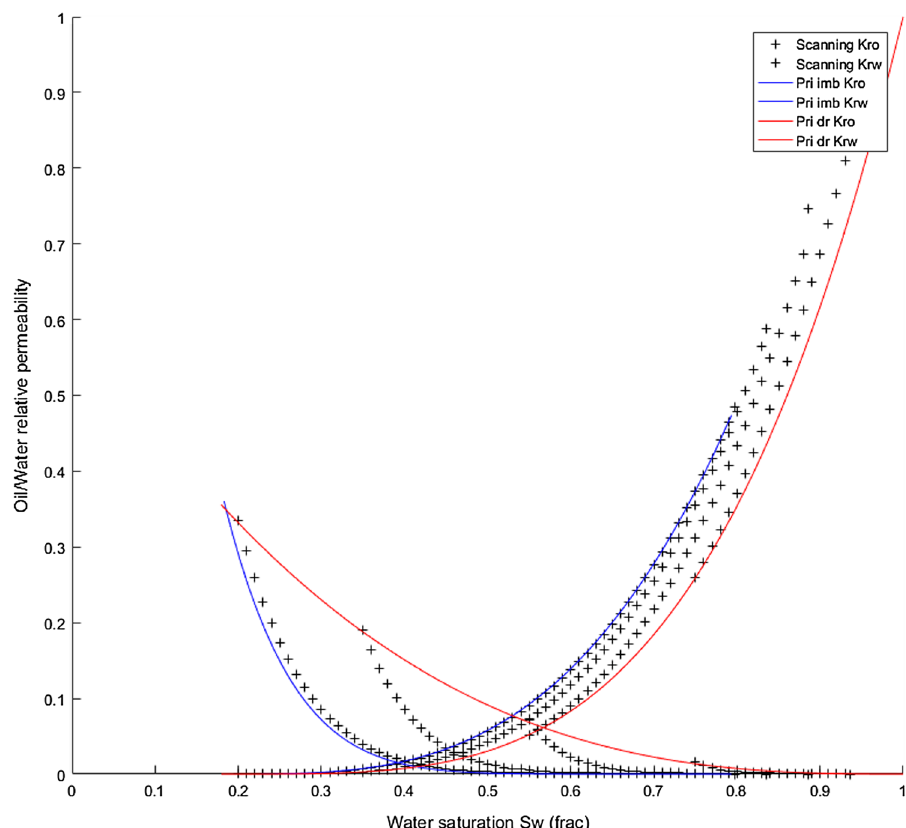
Fig. 17 Bounding drainage/ imbibition curve and scan- ning curve for rock type 5 (Masalmeh model, linear-type S S oi / or relationship)